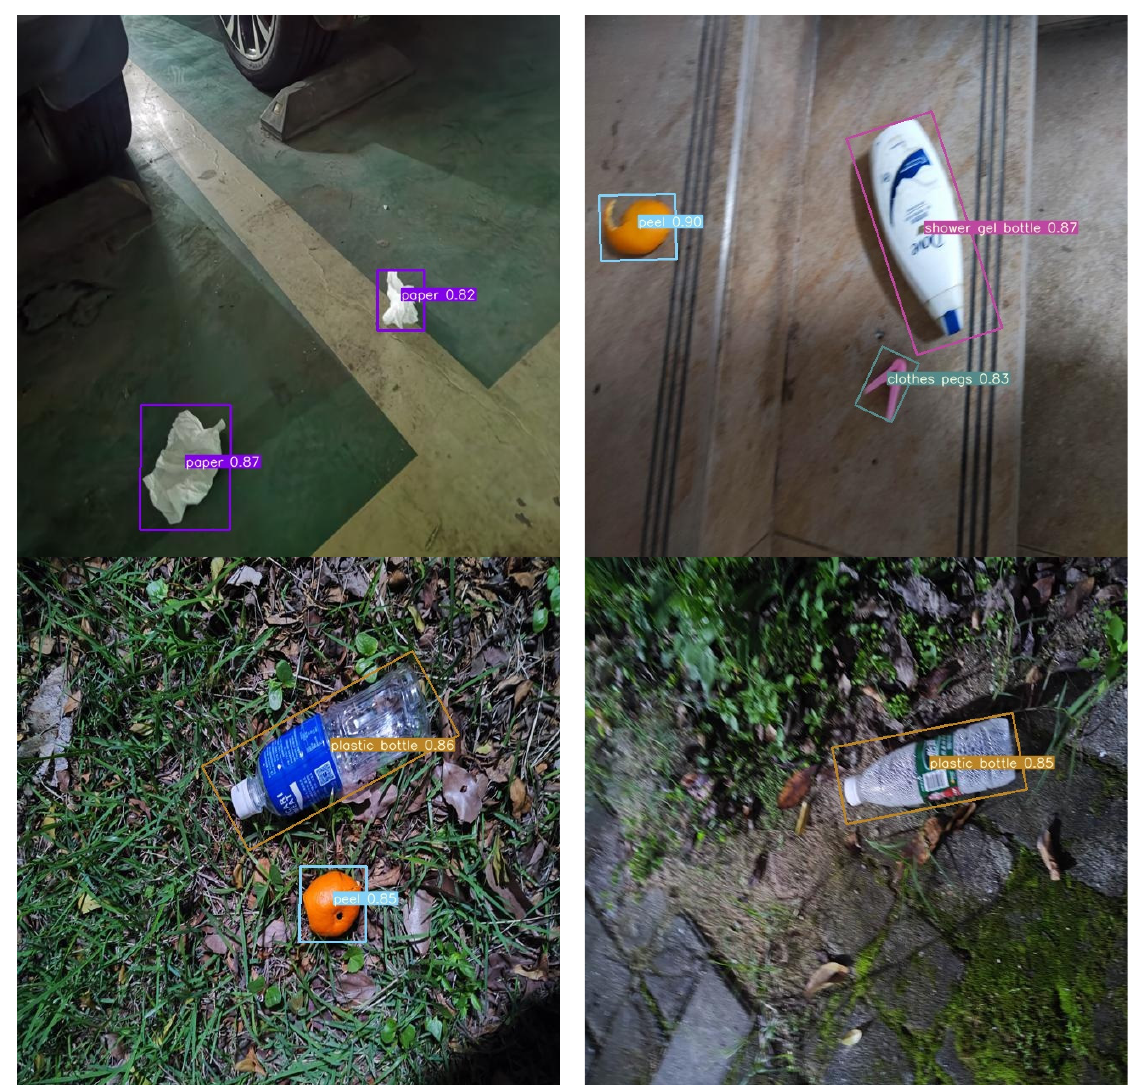
Figure 13. Waste detection with YOLOv5m-DSM in different scenarios.